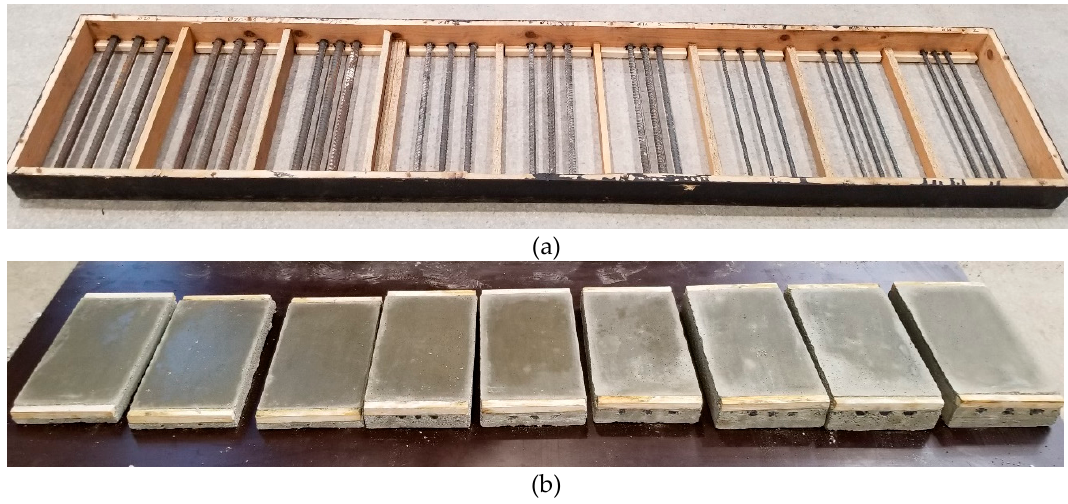
Figure 8. Specimen reinforcement in formwork ( a ) and specimens after concreting ( b )